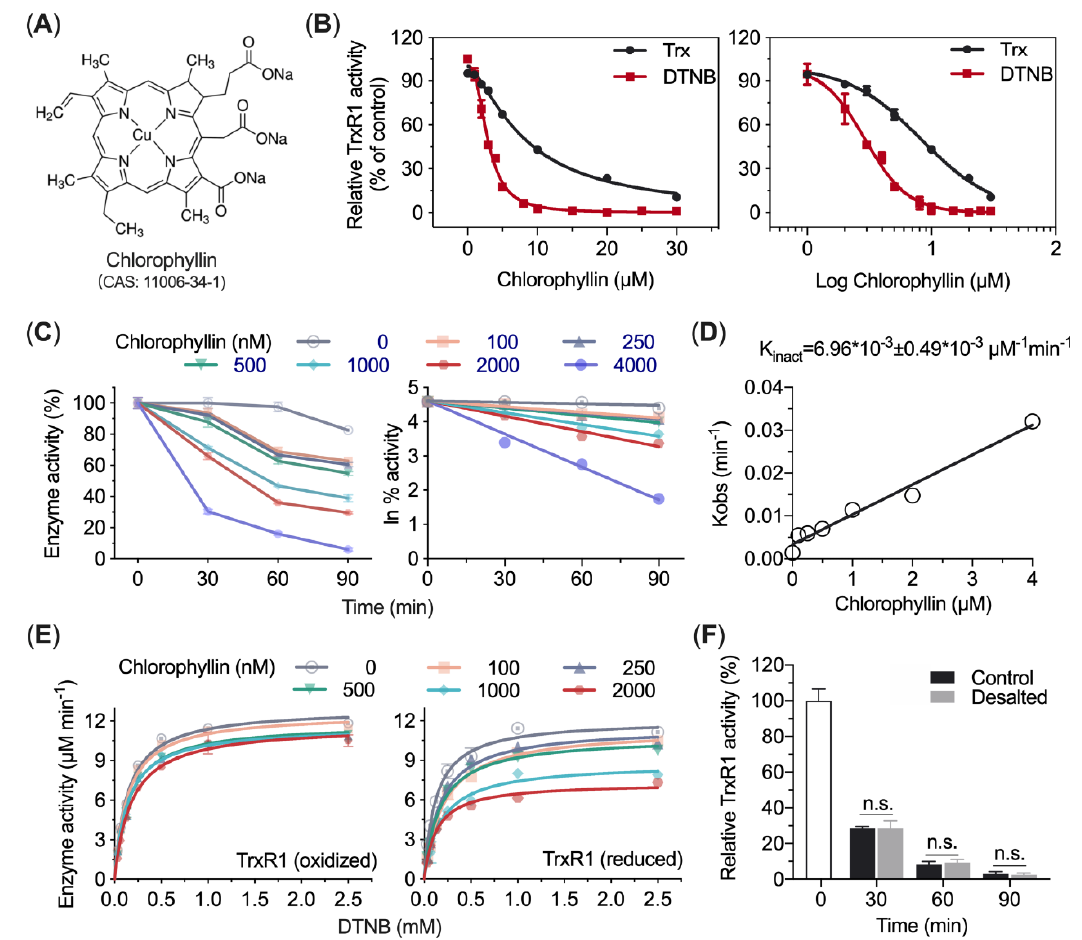
Figure 5. Inhibitory effect of chlorophyllin on TrxR1 enzymatic activity and kinetic behavior. ( A ) Chemical structure of chlorophyllin. ( B ) Chlorophyllin inhibits both DTNB reduction activity and Trx-coupled insulin reduction activity of TrxR1. ( C ) Time-dependent inhibition of TrxR by chlorophyllin. TrxR1 was incubated with different concentrations of chlorophyllin for different times, and the enzyme activity was determined with DTNB as substrate, which was normalized with the untreated enzyme. The remaining activity of TrxR1 was converted to Napierian logarithm, and the K obs and K inact were shown in ( D ) with chlorophyllin ranging from 0 to 4 µM. ( E ) Chlorophyllin inhibits reduced TrxR1 rather than oxidized TrxR1. TrxR1 was pre-reduced by NADPH or not and incubated with different concentrations of chlorophyllin for 1 h. Subsequently, the enzyme activity was tested by DTNB reducing assay. ( F ) The inhibition of chlorophyllin on TrxR1 is irreversible. 0.5 µM TrxR1 was incubated with 3 µM chlorophyll, and the free chlorophyll was removed by NAP -5 TM column (Cytiva TM , Uppsala, Sweden) at the indicated time. The enzyme activity was determined by using DTNB as a substrate. n.s. means not significant.